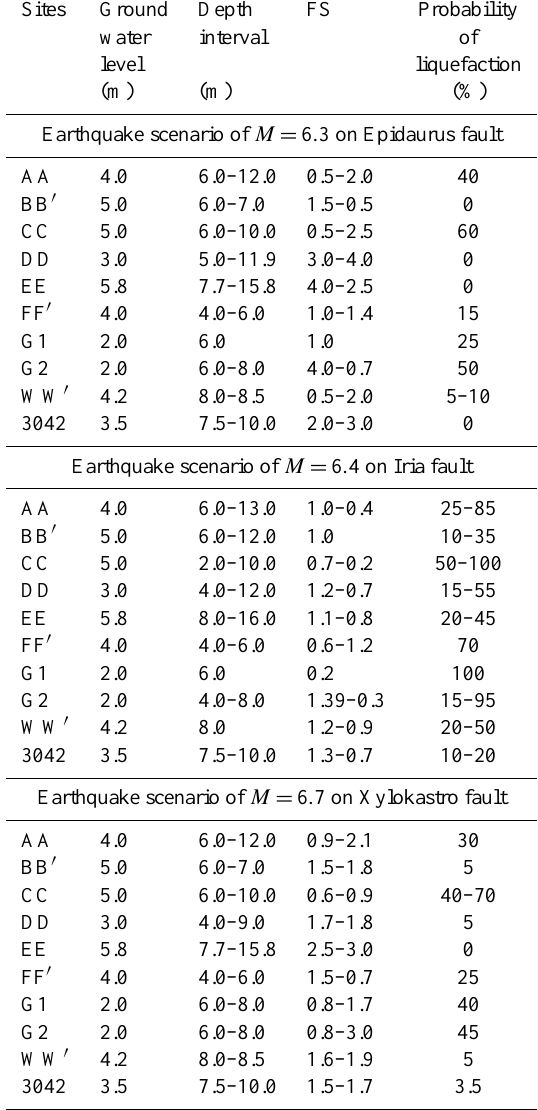
Table 3. Results of the liquefaction risk analysis at the examined sites. Depths of the water table – and of the potentially liquefiable layer are also